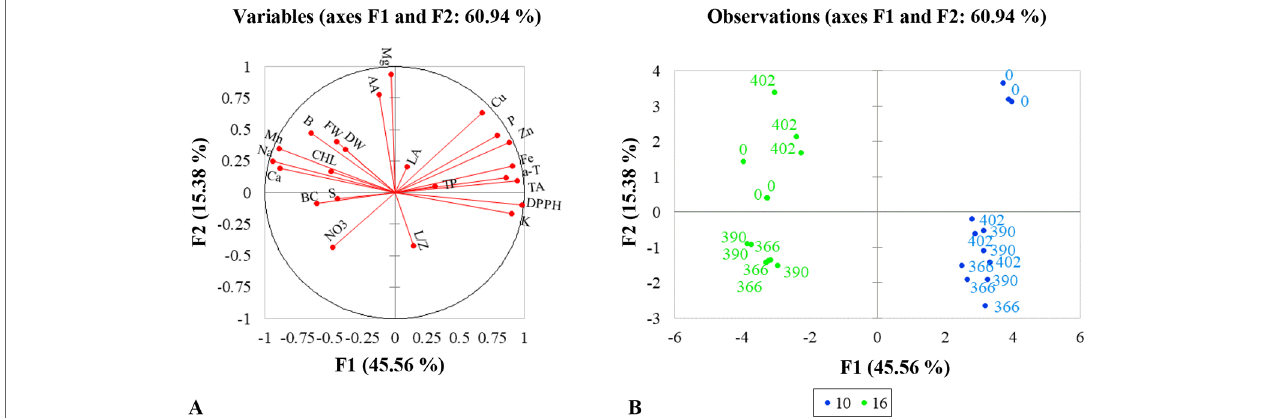
FIGURE 4 | Multivariate principal component analysis showing the effect of supplemental UV-A LED radiation on mustard microgreens. (A) Correlation circle, summarizing metabolic relations between investigated parameters under different lighting conditions. LA, leaf area; FW, fresh weight; DW, dry weight; CHL, chlorophyll index; TP, total phenols; TA, total anthocyanins; DPPH, DPPH• radical-scavenging activity; AA, ascorbic acids; α -T, α -tocopherol; L/Z, lutein/zeaxanthin; BC, β -carotene; NO 3 , nitrates; P, phosphorus; K, potassium; Ca, calcium; Mg, magnesium; Na, sodium; S, sulfur; Mn, manganese; Fe, iron; Zn, zinc; Cu, copper; B, boron. (B) PCA scatter plot, indicating distinct growth and metabolism in mustard under different lighting conditions. 0—standard irradiance without UV-A radiation; 366, 390, 402—wavelengths (nm) of UV-A radiation; 10, 16—duration in hours of UV-A radiation in standard irradiance. The significance level was set at P ≤ 0.05 for the